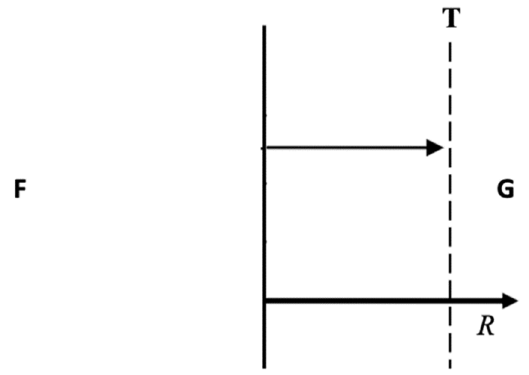
Figure 3. Divinity’s Power Modelled as a Vector.